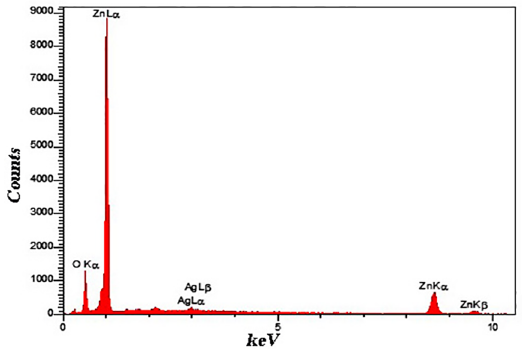
Figure 6. EDX spectrum measured for ZnO/Ag bilayer thin